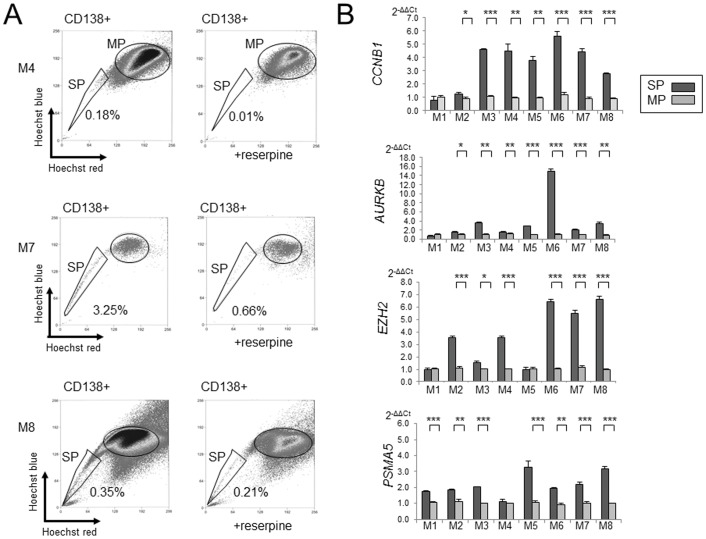
SP analysis in primary MM samples and gene expression analysis.(A). SP of primary samples (M4, M7 and M8). Left panel: cells obtained through bone marrow aspiration gated for CD138+ with and without 50 µM reserpine. SP fractions (%) are shown beside the SP gates surrounded by black lines. (B). Real time PCR analysis of eight samples of MM primary tumor cells. Shown bar graphs are CCNB1, EZH2, AURKB and PSMA5 in SP and MP cells of indicated five myeloma cell lines. Y-axis: gray and white bars depict 2−ΔΔCt values for gene expression. Asterisks (*) indicate statistical significance: *0.01≤P<0.05, **0.001≤P<0.01, ***P<0.001. Bars are means ± SD of triplicate samples.